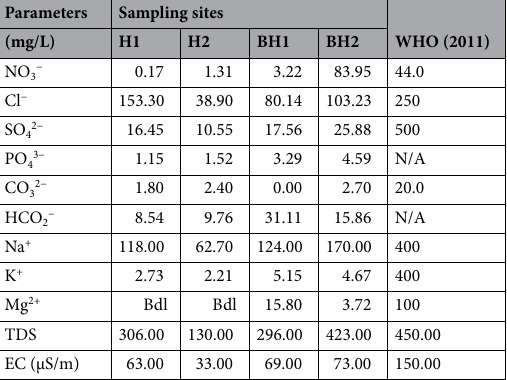
Table 3. Chemical parameters of groundwater. STD N/A Not available, H1 & H2 individual borehole 1 & 2, BH1 & BH2 monitoring borehole 1 & 2, Bdl Below detection